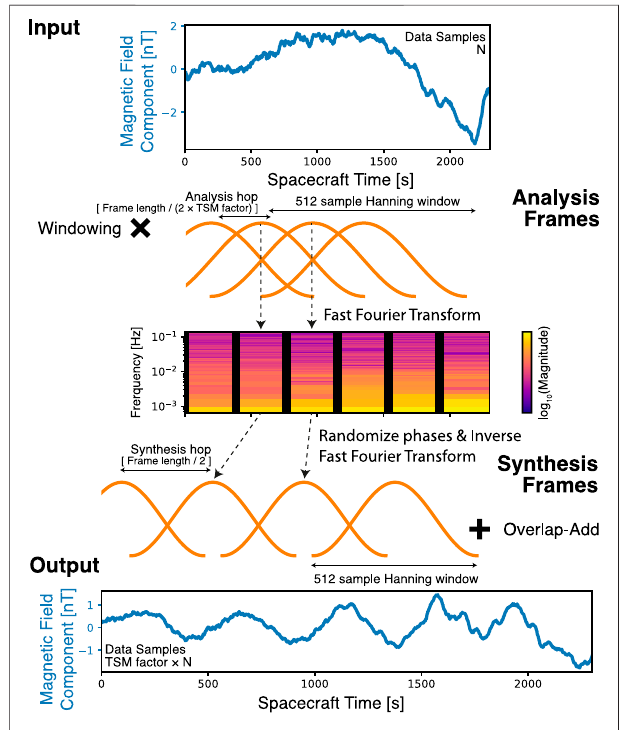
FIGURE 5 | Illustration of the PaulStretch